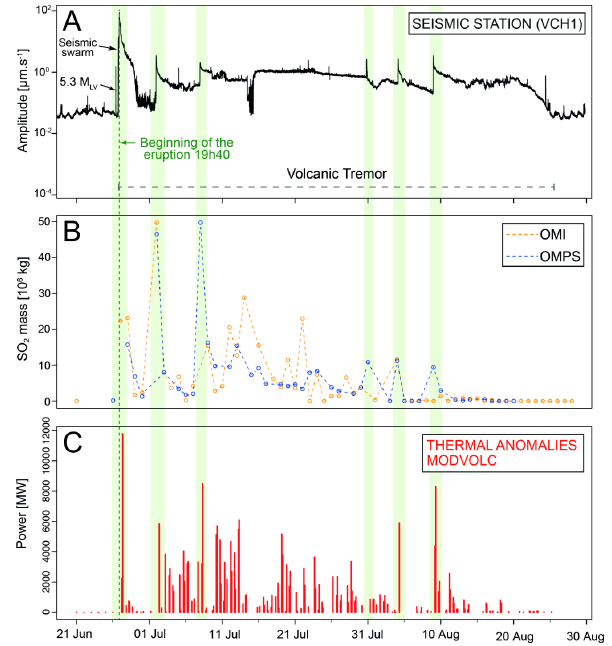
Figure 4: Composite image of the monitoring parame- ters at Sierra Negra volcano, from 21 June to 30 August 2018. Green dashed-line marks the beginning of the eruption and green bars show the main eruptive pulse. [A] Median Seismic Amplitude data (station VCH1, see Figure 5 for the location) in 10-minute windows are cor- rected for instrument response and filtered between 1 – 8 Hz. [B] Time series of SO 2 mass recorded by OMI and OMPS satellite instruments. Data downloaded from https://so2.gsfc.nasa.gov/pix/daily/0718. [C] Thermal anomalies recorded by MODVOLC. Data downloaded from